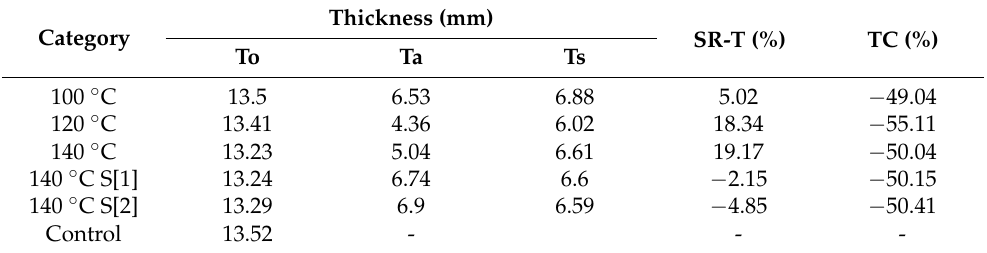
Table 4. The thickness of Albizia falcataria before and after densification treatment.